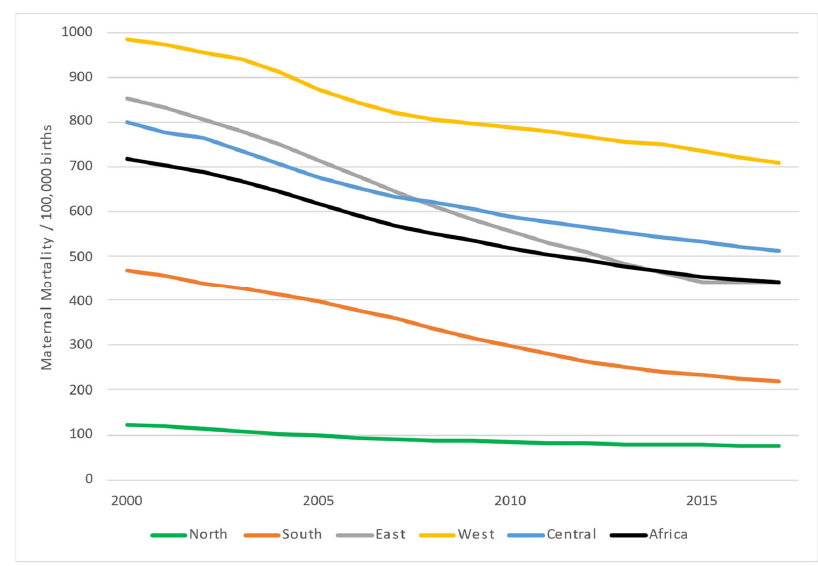
Figure 2. Evolution of maternal mortality rates in Africa (2000–2017). Int. J. Environ. Res. Public Health 2022 , 19 , 13146